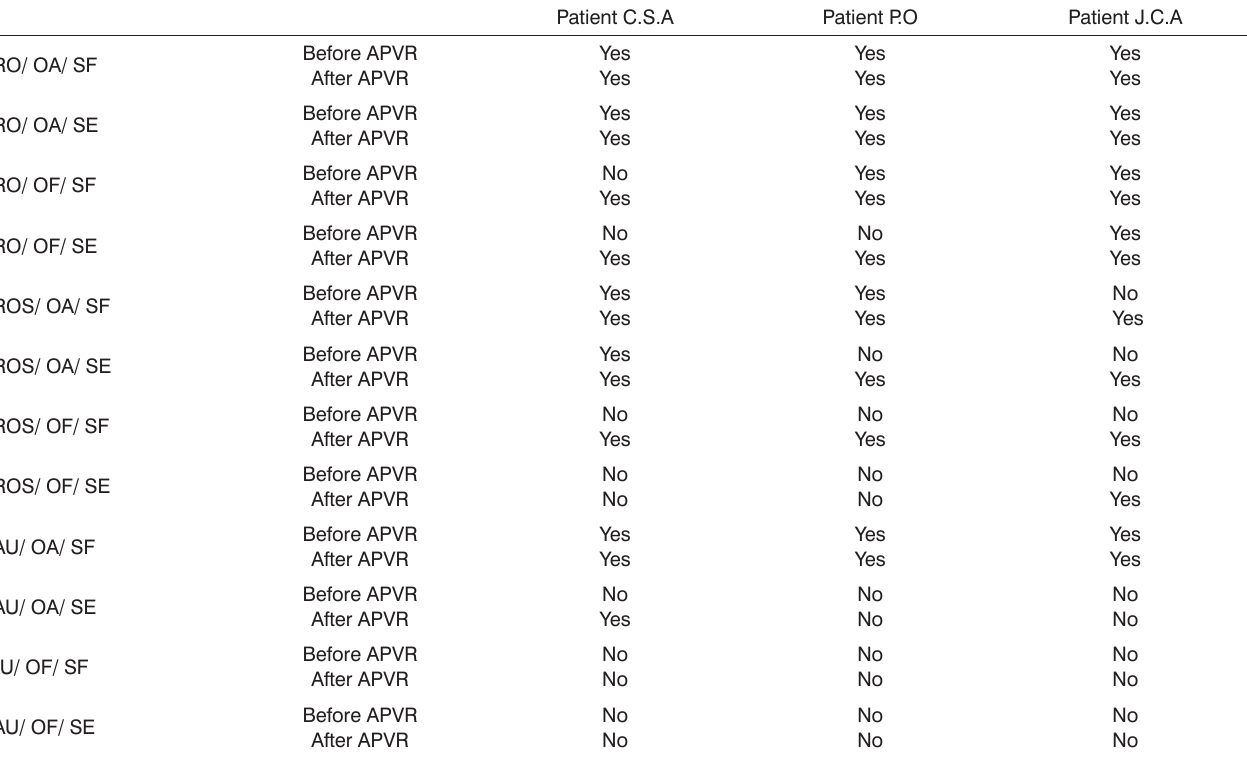
Chart 3. Results from balance evaluation of the 3 patients with persistent Benign Paroxysmal Positional Vertigo treated with the Vestibular Rehabilitation Aquatic Physical Therapy